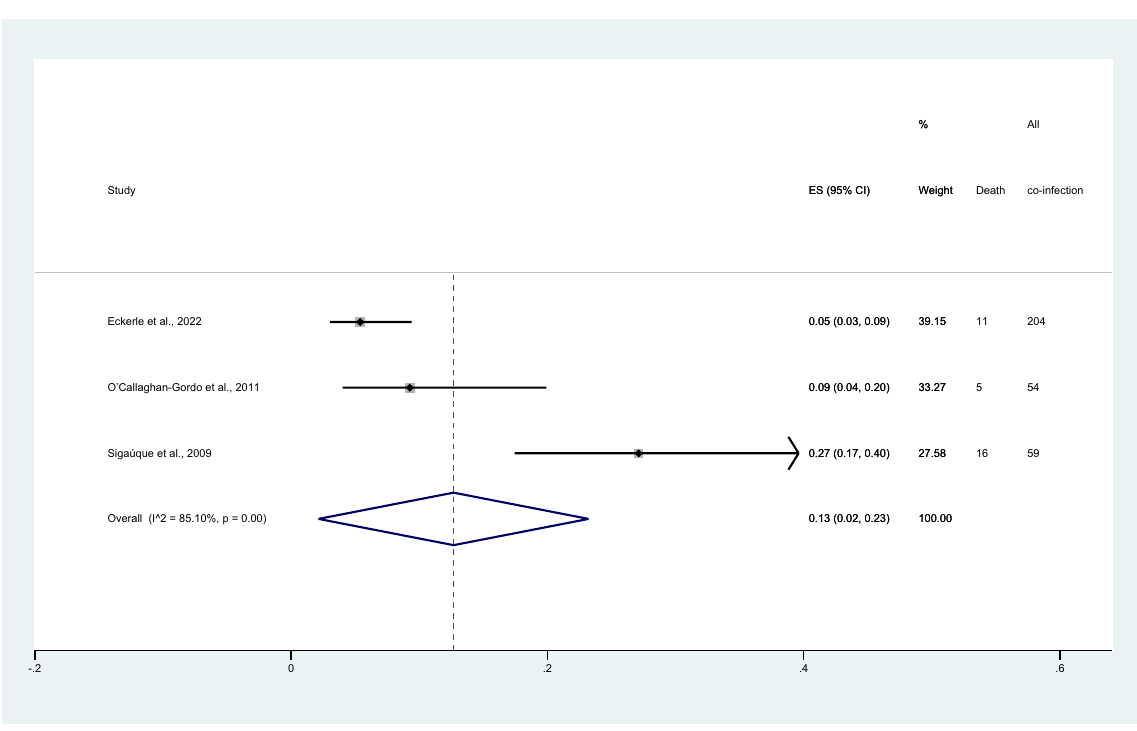
Figure 6. Forest plot demonstrates the pooled proportion of deaths among patients with co-infection. ES, proportion estimate; CI, confidence